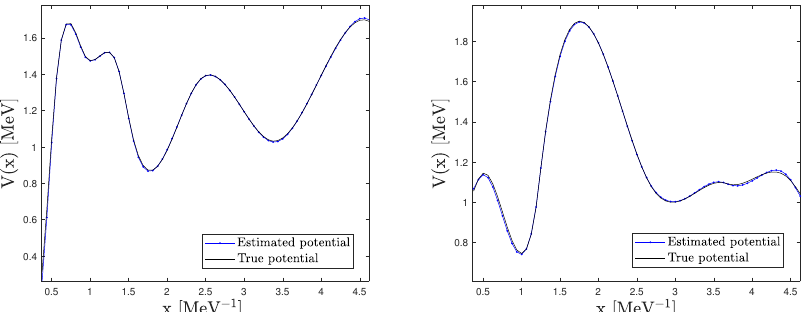
Figure 8. Comparison of the true potential and the calculated potential from the Volterra model in two different cases. The black lines are the true potentials, while the blue dotted lines are the model calculations given by the identified 5th order Volterra